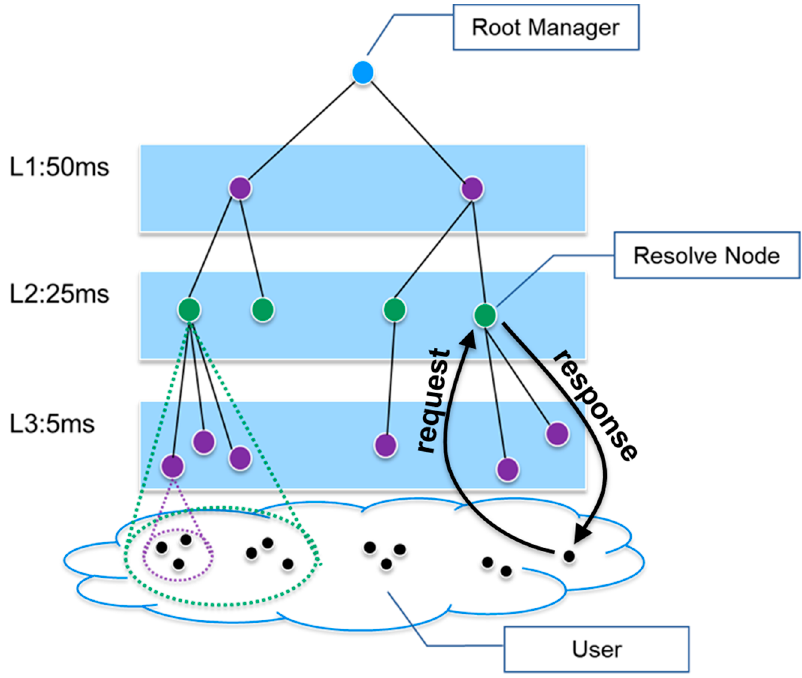
Figure 1. LNMRS implementation based on the tree structure.